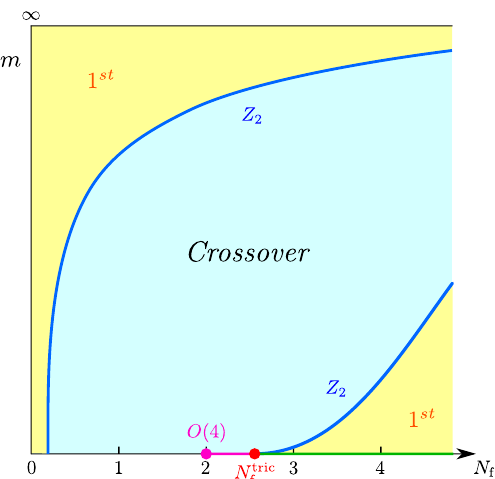
Figure 4. Columbia plot for mass-degenerate quarks. Every point represents a phase boundary and has an implicitly associated T c ( m, N f ) .